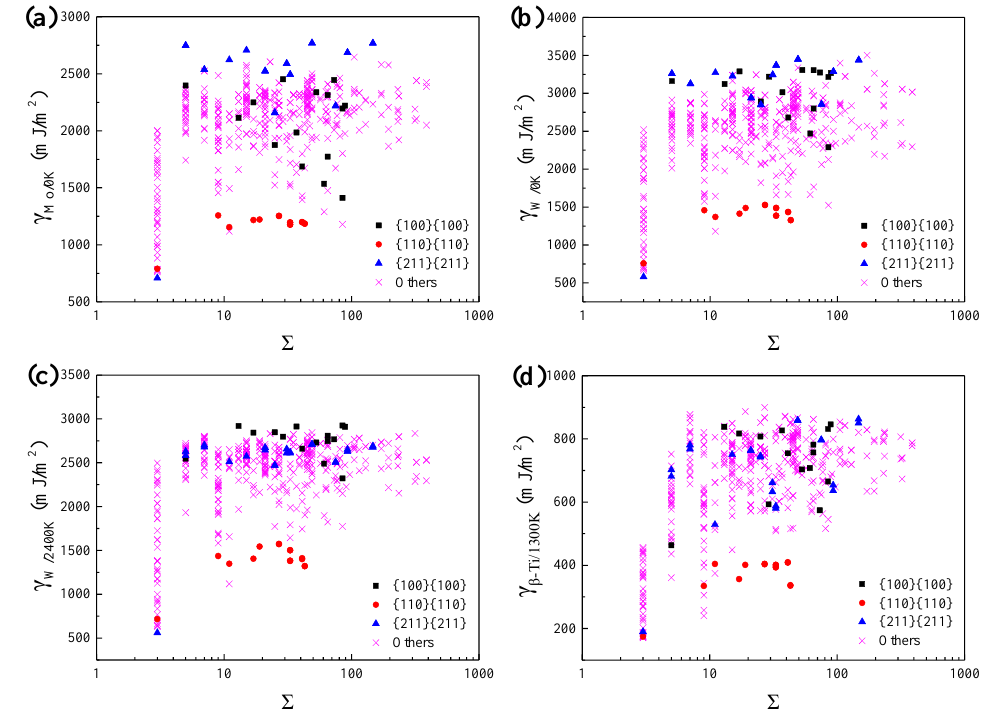
Figure 2. The calculated grain boundary energies (GBEs) of ( a ) Mo at 0 K, ( b ) W at 0 K, ( c ) W at 2400 K, and ( d ) β -Ti at 1300 K as a function of the ∑ value. The black squares, red dots, blue triangles, and purple crosses correspond to the GBs with the GB planes of {100}{100}, {110}{110}, {211}{211}, and others, respectively.